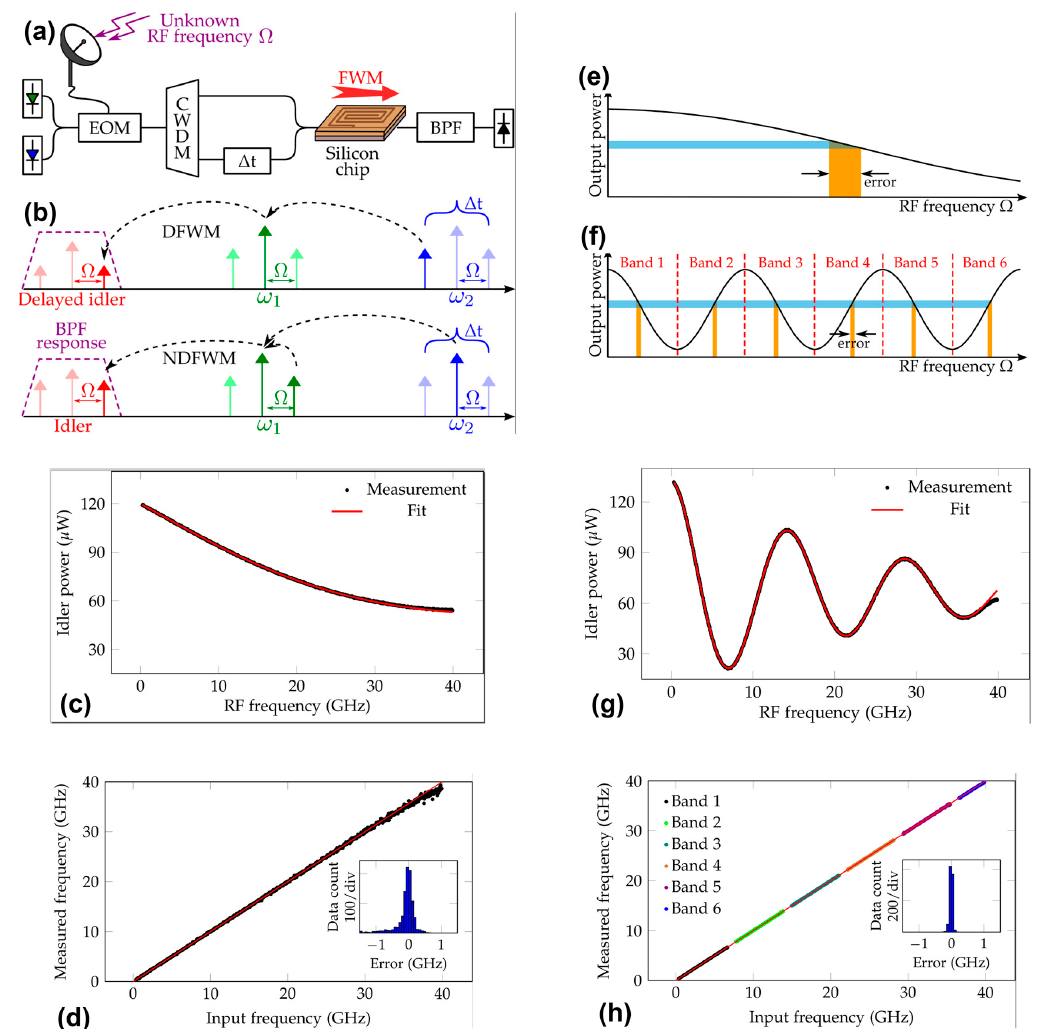
Figure 14. ( a ) Schematic of the on-chip four wave mixing (FWM)-based instantaneous frequency measurement (IFM) system reported in [104]. 𝛥𝑡 : tunable delay element; BPF: optical bandpass filter. ( b ) DFWM and NDFWM mixing processes between the two channels. ( c ) IFM RF system response with 𝛥𝑡 = 8.3 ps. ( d ) Frequency estimation measurement over a single 40 GHz frequency band (inset, histogram of the frequency measurement error; rms value = 318.9 MHz). Reconfiguration of the IFM system response between ( e ) a high-bandwidth/error state (low 𝛥𝑡 ) and ( f ) a low-bandwidth/error state (high 𝛥𝑡 )). ( g ) IFM system response with 𝛥𝑡 = 69.4 ps. ( h ) Frequency estimation measurement for six separate 7.2 GHz frequency bands (inset, histogram of the frequency measurement error; rms value = 40.2 MHz). Courtesy of David Marpaung [104].